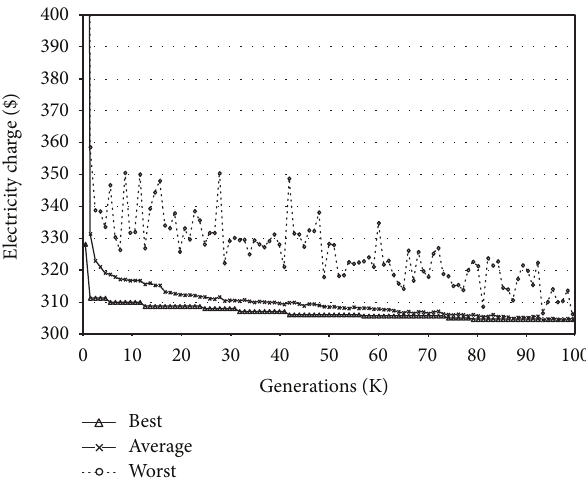
Figure 9: Convergence of the scheduling set as time